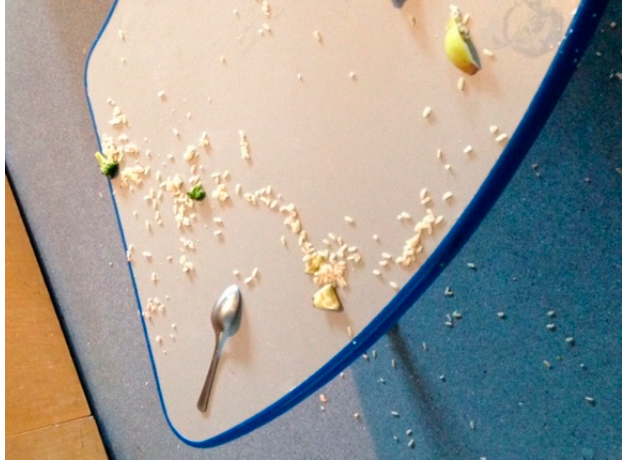
Figure 2. Spillage of rice and other items served to a preschooler in Study 1 (observational feeding study with preschoolers and parent reporters).